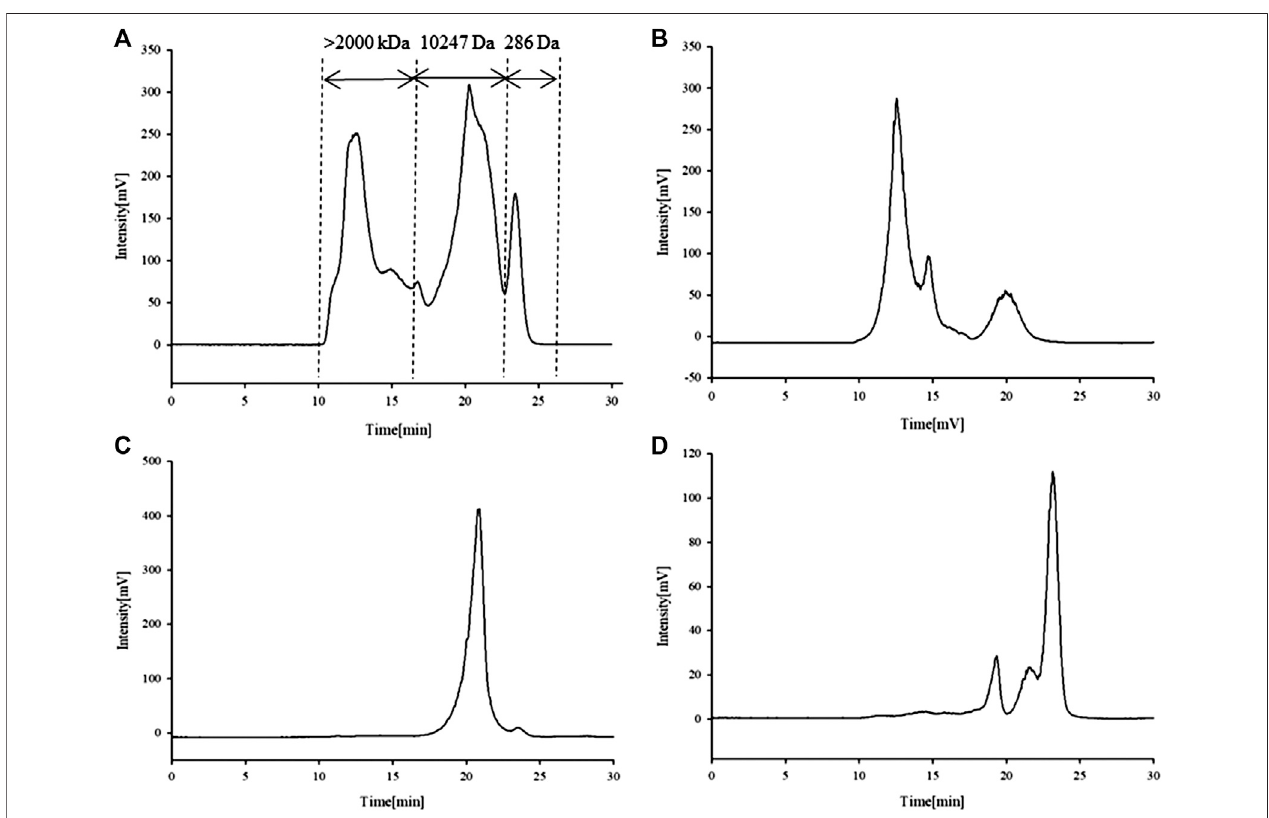
FIGURE 1 | Chromatogram of APS determined high-performance liquid chromatography (HPLC-ELSD). APS (A) , APS-I (B) , APS-II (C) , APS-III (D) .